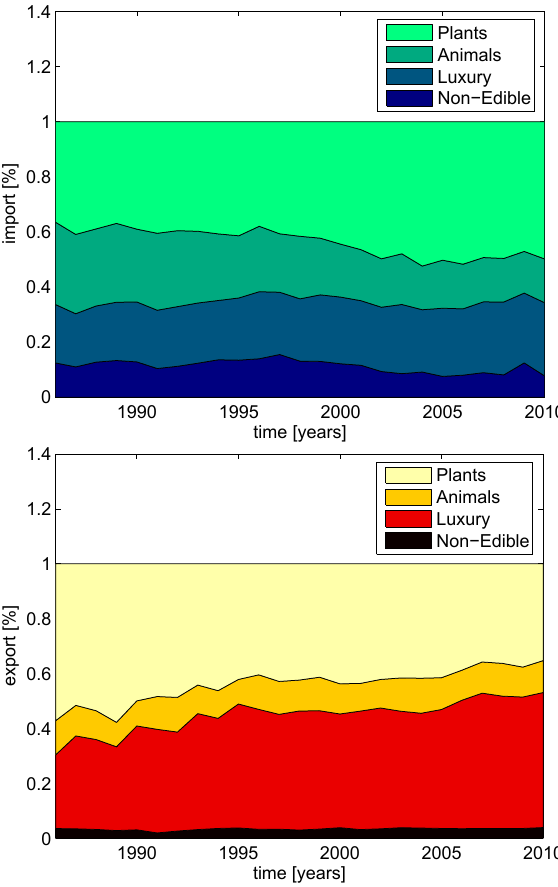
Fig. 9. Average distance travelled by virtual water associated to dif- ferent categories of goods (upper panel: plant-based products, bot- tom panel: animal-based